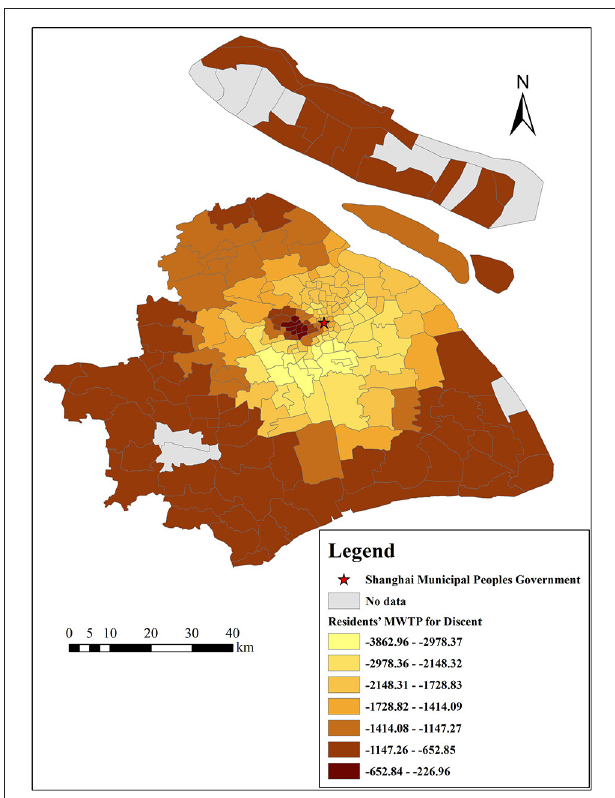
FIGURE 16 | The spatial heterogeneity of MWTP for the distance from the city